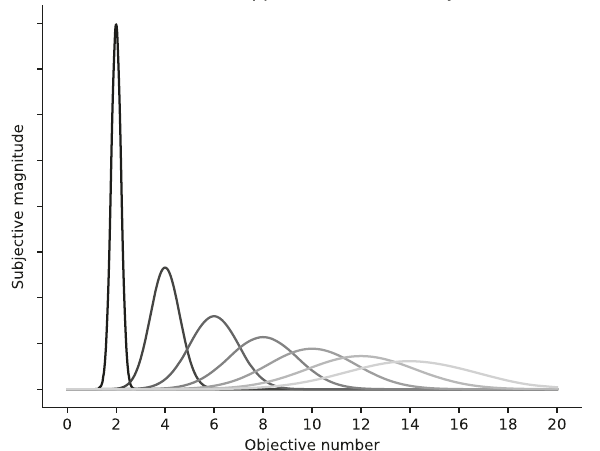
Fig. 2 Schematic model of the approximate representation of numerical quantities. Numbers are represented as Gaussian distributions with a scalar variability (i.e., Weber ’ s law). The increased variability with larger numbers re fl ects greater uncertainty to represent these numerical